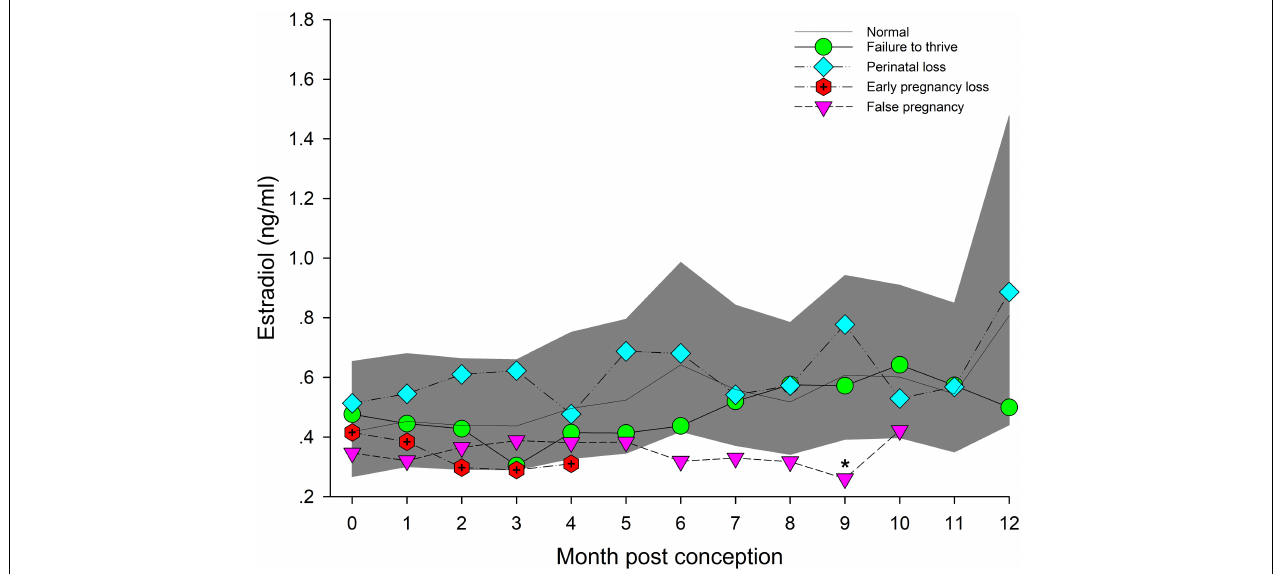
FIGURE 4 | The marginal predicted 95% CI for estradiol during each month post-conception (MPC) of normal pregnancies as represented by the dark gray shaded portion of the graph and the mean by a solid black line. Line graphs with data points represent each abnormal pregnancy (marginal mean). MPC of abnormal pregnancies which have mean concentrations that are significantly different from normal are highlighted with an asterisk (*). Data were log transformed for analysis and then back-transformed for data presentation.